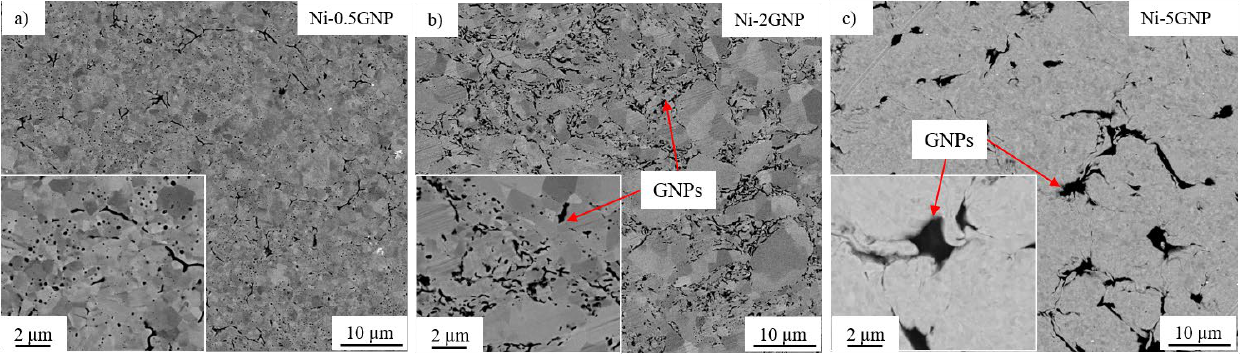
Figure 4. SEM micrographs of ( a ) Ni-0.5GNP, ( b ) Ni-2GNP, ( c ) Ni-5GNP composite.